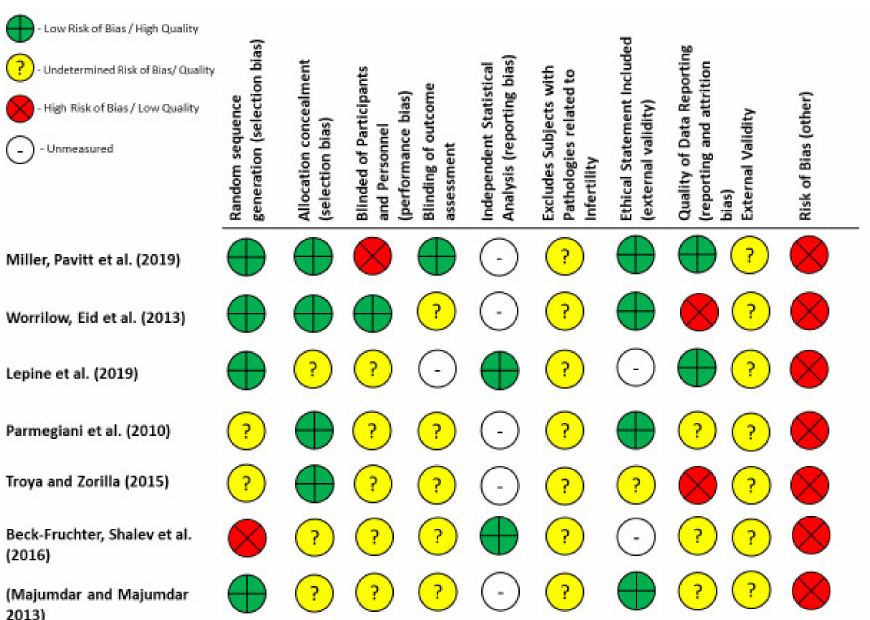
Figure 7. A summary of the authors’ judgement on quality and bias assessment results for studies included in study question 3—Does sperm selection by HAB improve clinical outcomes for all infertility patients? Green: low risk of bias/high quality, Yellow: undetermined risk of bias/quality, Red: high risk of bias/low quality, White: assessment does not apply.